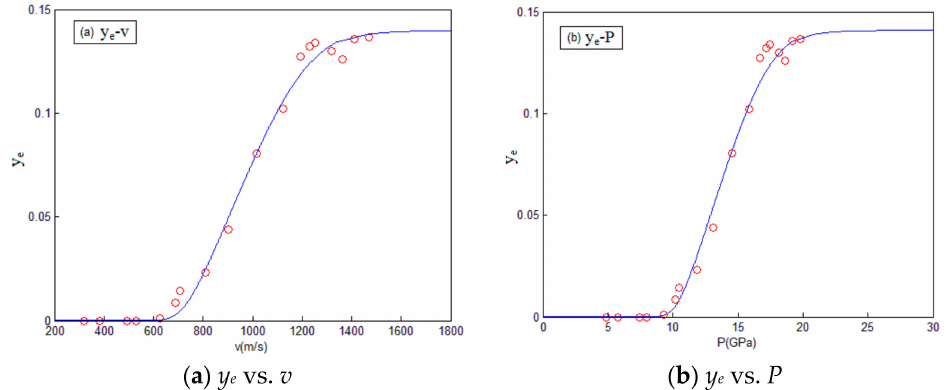
Figure 7. The relation between energy release efficiency, impact velocity, and impact pressure. ( a ) The relation between energy release efficiency and impact velocity; ( b ) The relation between energy release efficiency and impact pressure.